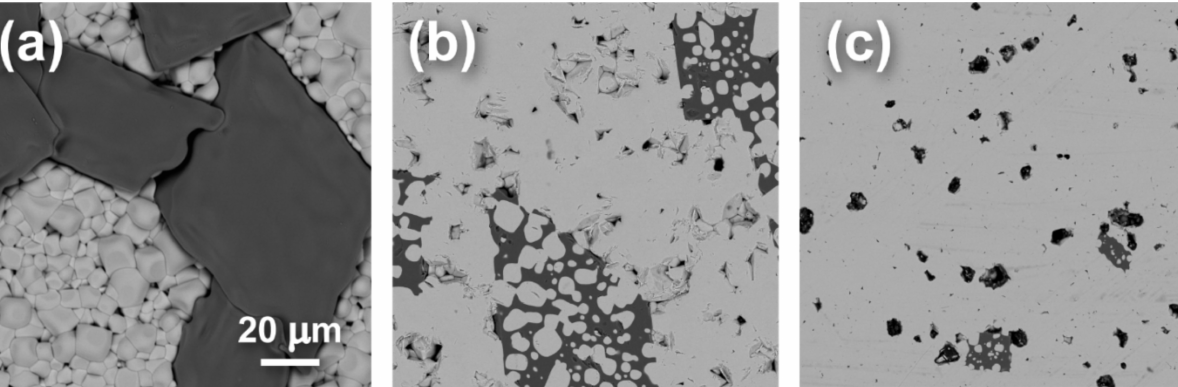
Figure 6. Surface of NBT-Eu ceramics thermally treated at 1240 ◦ C ( a ), as well as the surface of the same sample after slight polishing ( b ) and deeper polishing ( c